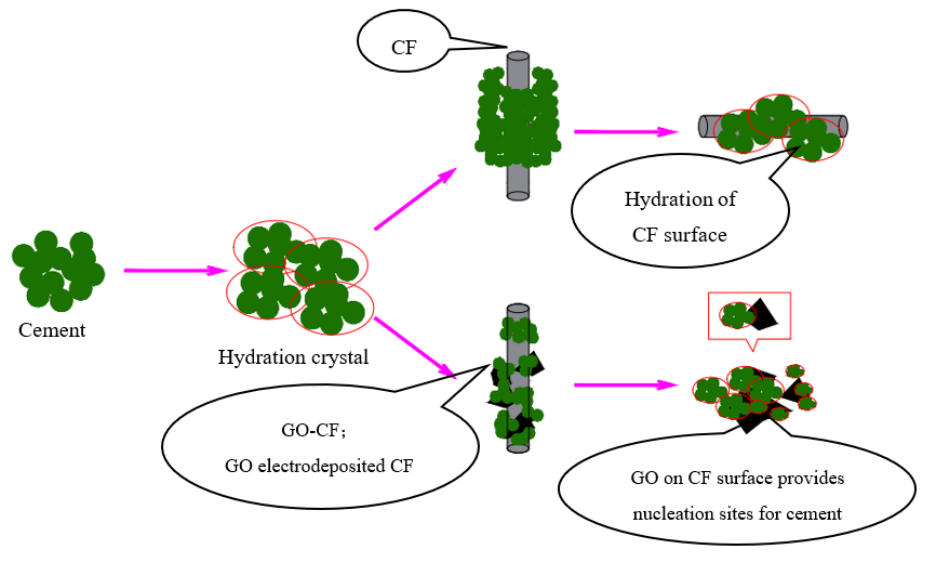
Figure 15. Schematic illustration of Hybrid effect of GO-CF to cement material.